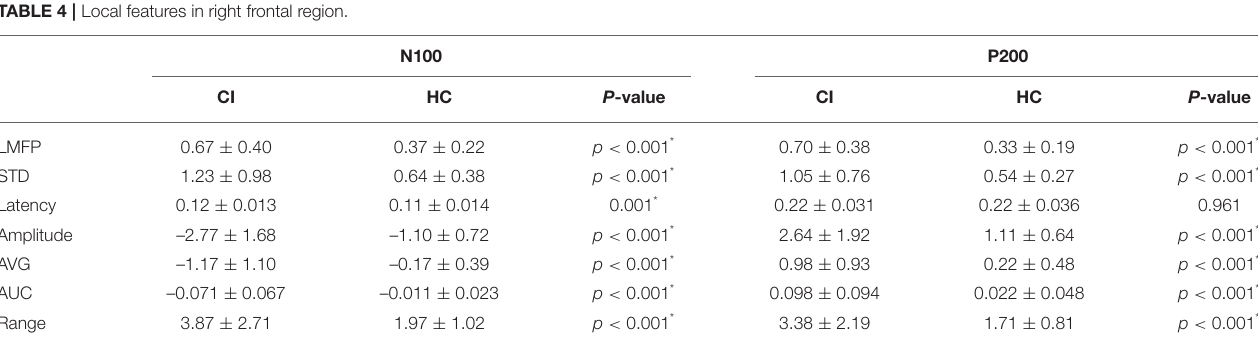
TABLE 4 | Local features in right frontal